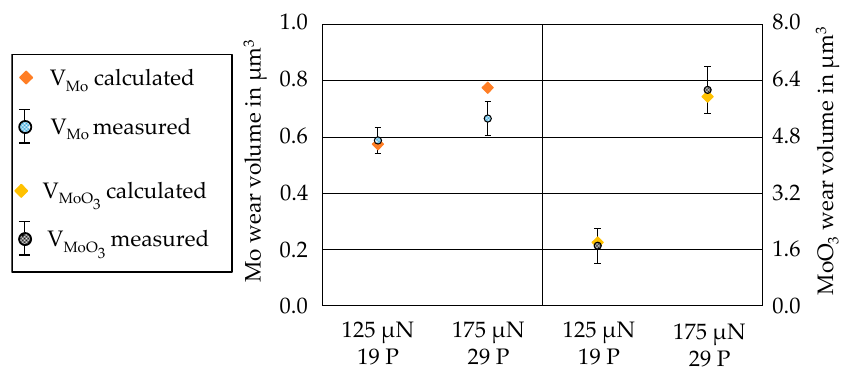
Figure 18. Comparison of the predicted and the experimentally determined wear volumes for Mo and MoO 3 .